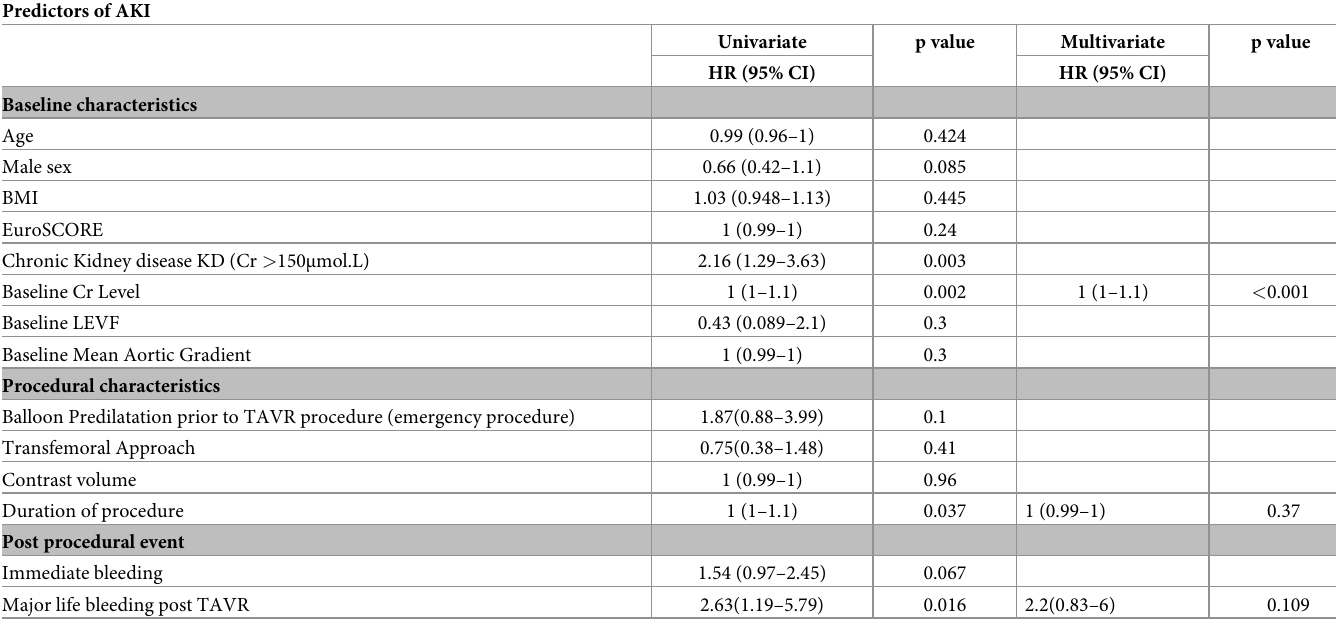
Table 6. Predictors of AKR after